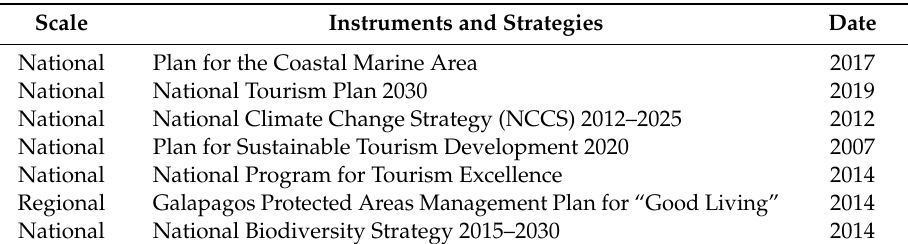
Table 8. Instruments of interest for the management of beaches in